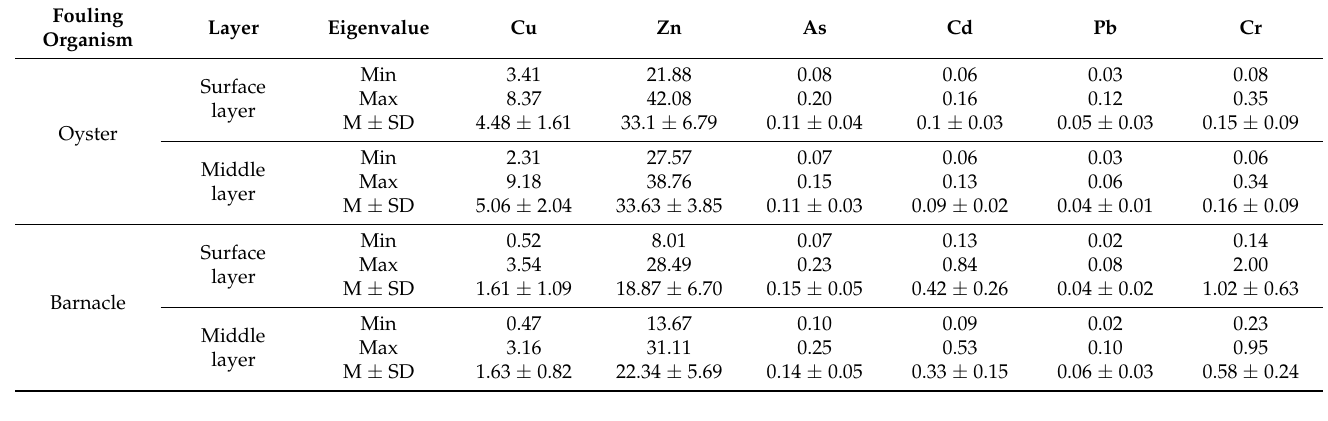
Table 3. Content changes in heavy metals in soft tissues of oyster and barnacle (wet weight).